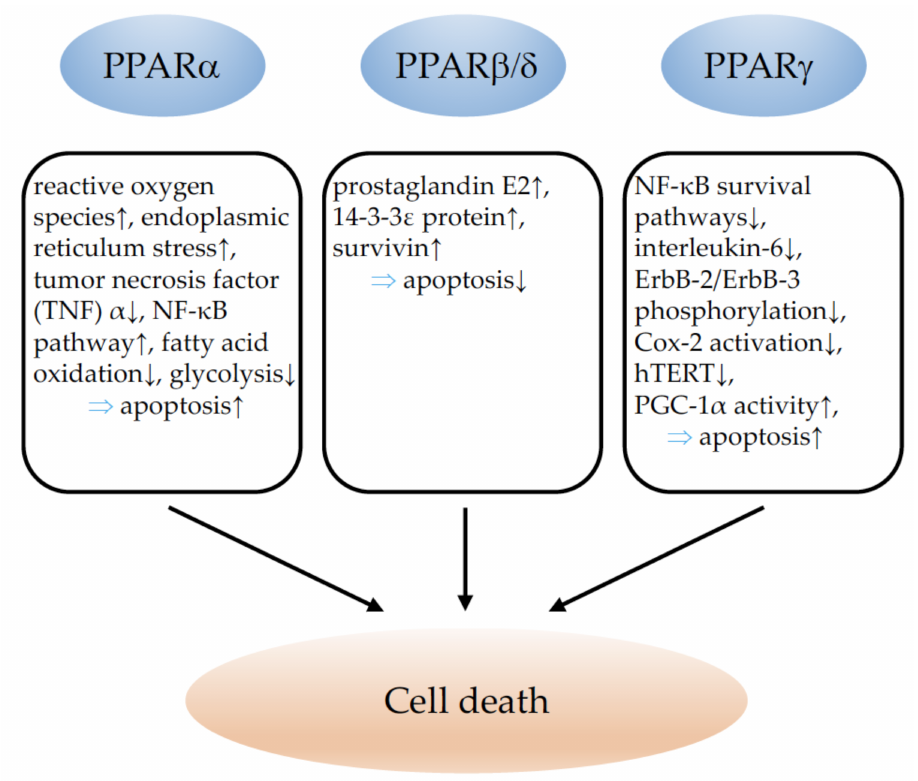
Figure 2. Illustration of the influence of PPAR α , PPAR β / δ , and PPAR γ on cancer-cell death. ↓ indicates inhibition and ↑ indicates an increase. ⇒ : leads to; TNF α : tumor necrosis factor al- pha; NF- κ B: nuclear factor kappa-light-chain-enhancer of activated B cells; Cox-2: cyclooxygenase-2; hTERT: telomerase reverse transcriptase human; PGC-1 α : peroxisome proliferator-activated receptor gamma coactivator-1